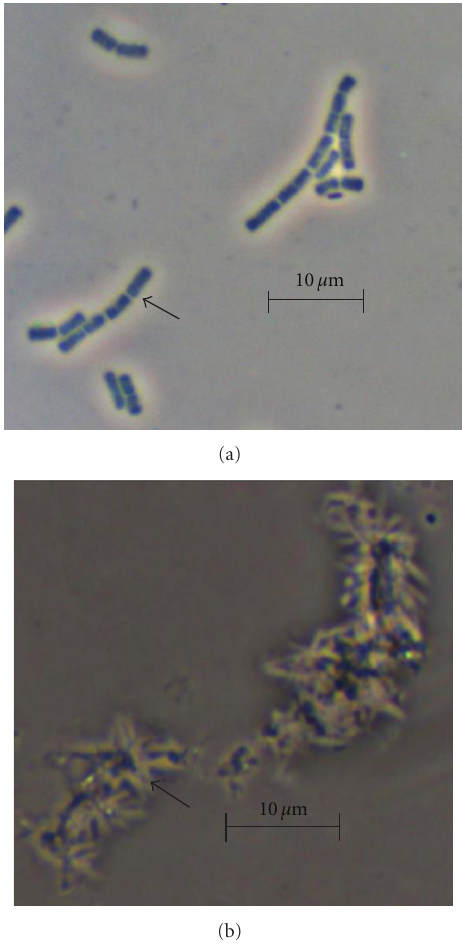
Figure 3: Micrographs of B. cereus 183 cells treated with Kurstacin 287. Samples were treated with bacteriocin, stained with amido black 10B (BioRad) for 5 min and observed under light microscopy. (a) B. cereus 183 cells without bacteriocin (control), (b) B. cereus 183 cells with Kurstacin 287. Black arrow in (a) and (b) show cells of B. cereus not damaged or lysed,